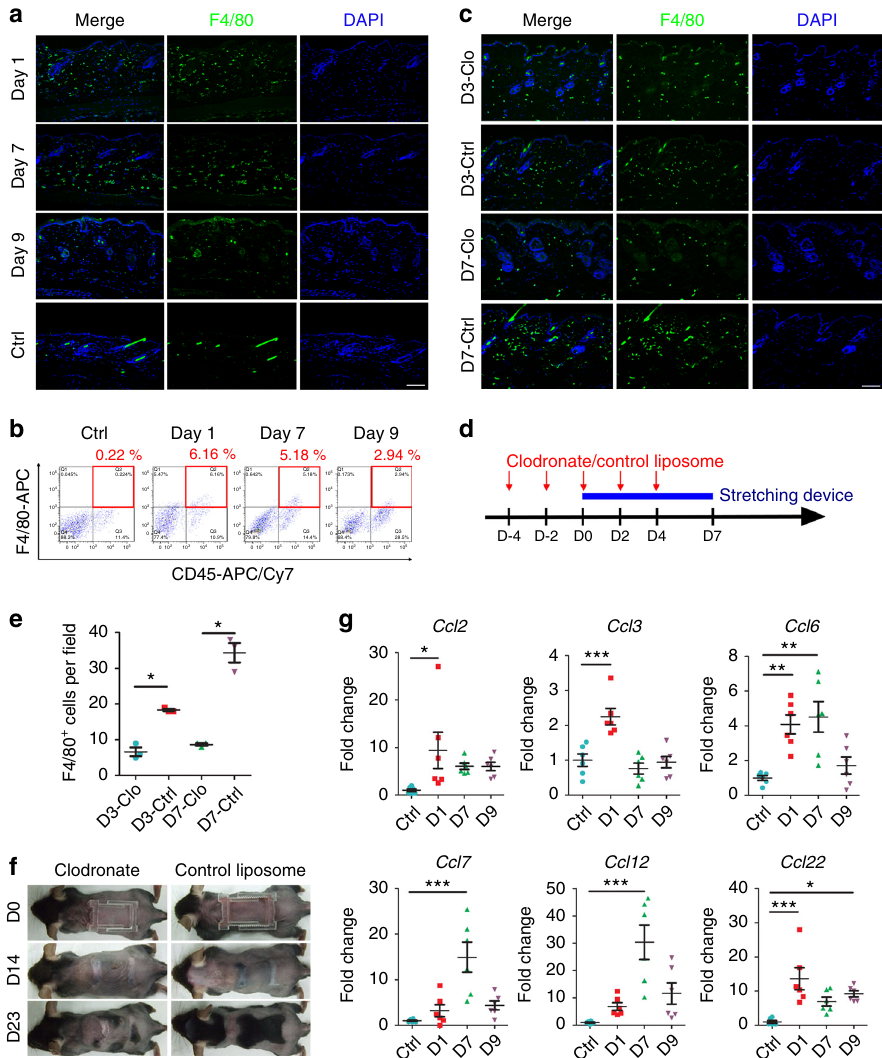
Fig. 4 Macrophages are major mediators in stretch-induced hair regeneration. a Immunostaining of F4/80 indicated extensive macrophage in fi ltration in response to stretch (day 1 and day 7) that was sustained after stretch was released (day 9). b Representative FACS scatterplots display the percentages of CD45 + F4/80 + cells activated in response to stretch (day 1 and day 7) and release of stretch (day 9). c Immunostaining of F4/80 revealed decreased macrophage in fi ltration after skin was stretched for 3 days and 7 days in the clodronate injection (Clo) group compared with the control liposome injection (Ctrl) group. d Schematic of subcutaneous injection of clodronate liposomes to target macrophages. e Quanti fi cation of F4/80 + cells in the Clo and Ctrl groups; n = 3 for each group. f Stretch-induced hair regeneration is halted by clodronate injection; n = 6 for each group. g Real-time PCR for Ccl2 , Ccl3 , Ccl6 , Ccl7 , Ccl12 , and Ccl22 in response to stretch (day 1 and day 7) and release of stretch (day 9); n = 6 for each group. Statistical signi fi cance was determined using Student ’ s two-tailed t -test ( e ) or ANOVA followed by a Bonferroni post hoc test ( g ). Data are presented as means ± SEM. * p < 0.05. ** p < 0.01. *** p < 0.001. Scale bars = 100 μ m. Source data are provided as a Source Data fi